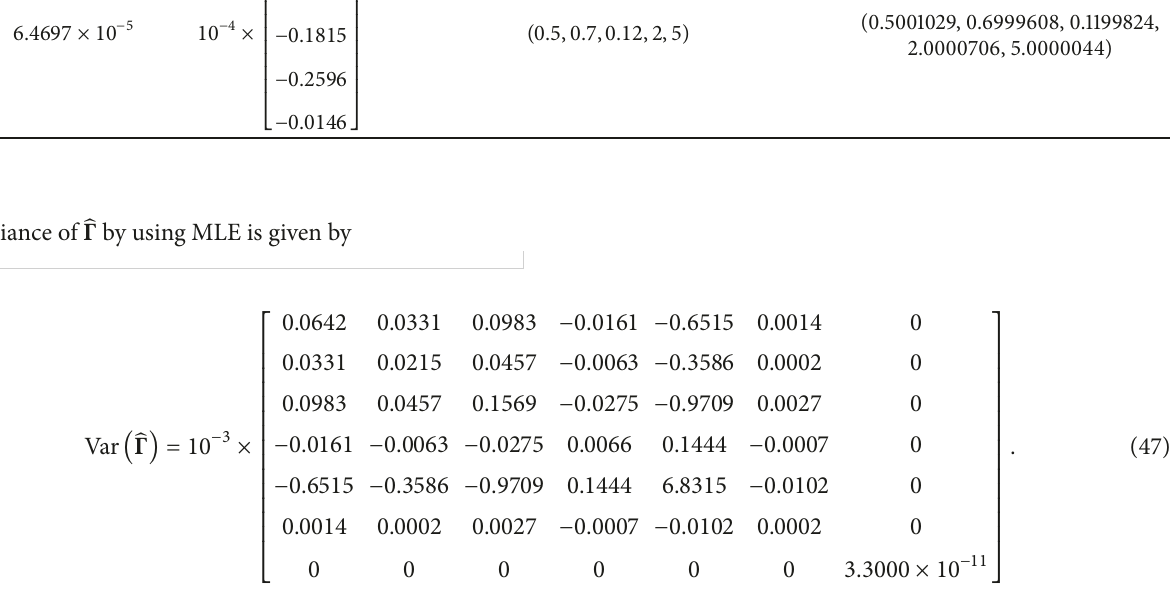
(̂𝜃 , ̂𝜃 , ̂𝜃 , ̂𝜏 , ̂𝜏 ) , and ̂𝜎 2 in DLDEM with two delays by using an adaptive grid 1 2 3 2 1